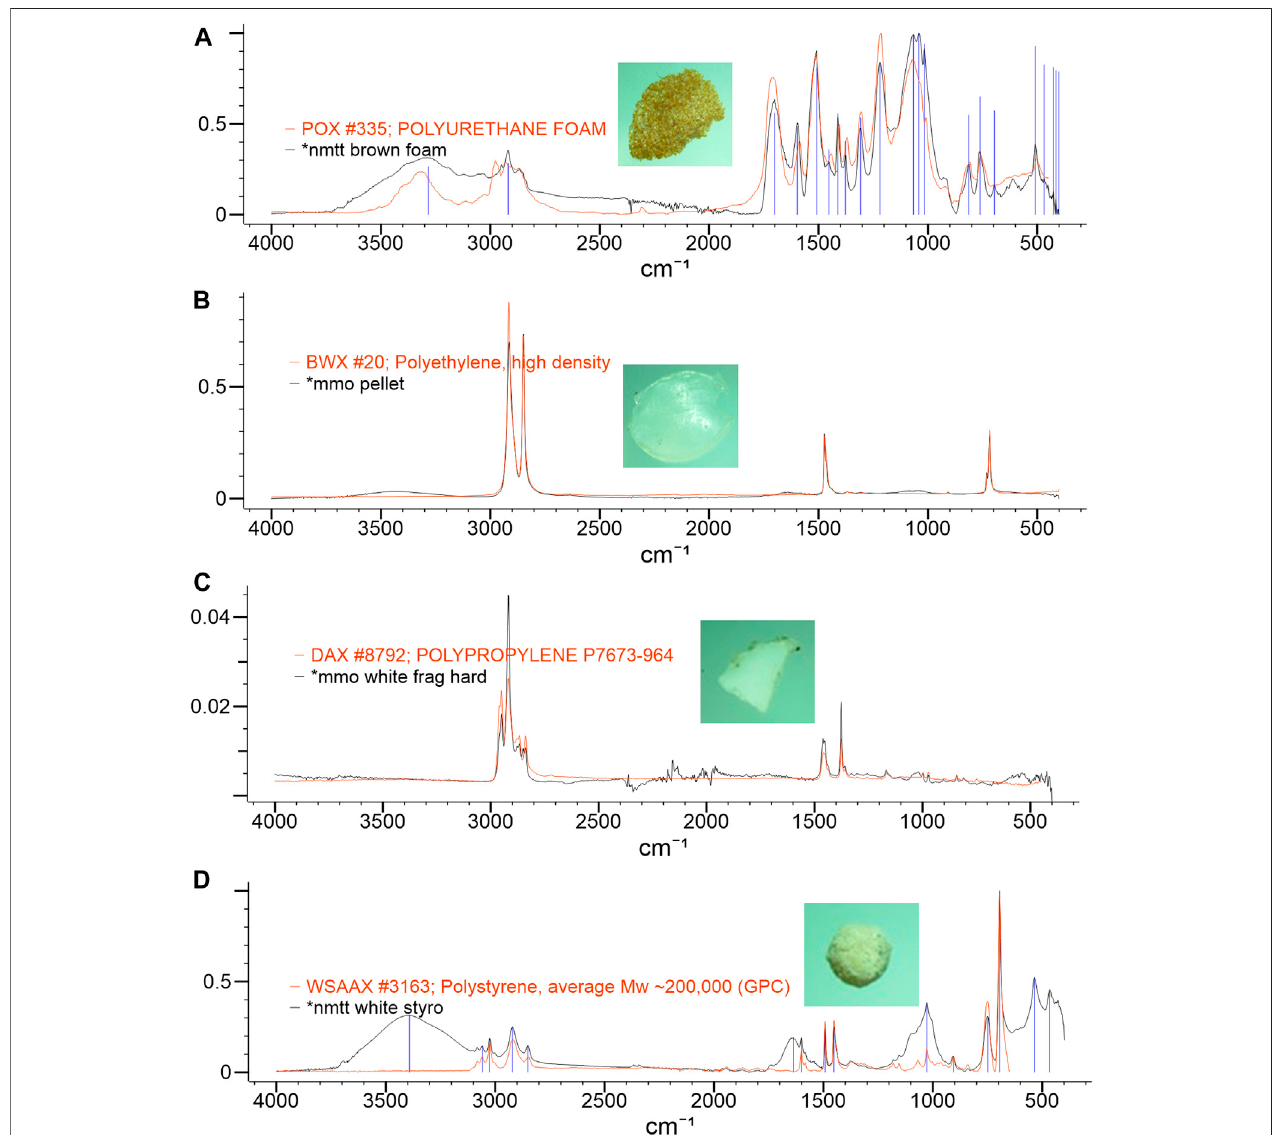
FIGURE 5 | Spectrum for (A) brown foam identi fi ed as PU, (B) white pellet identi fi ed as HDPE, (C) white fragment identi fi ed as PP, and (D) white foam identi fi ed as PS.